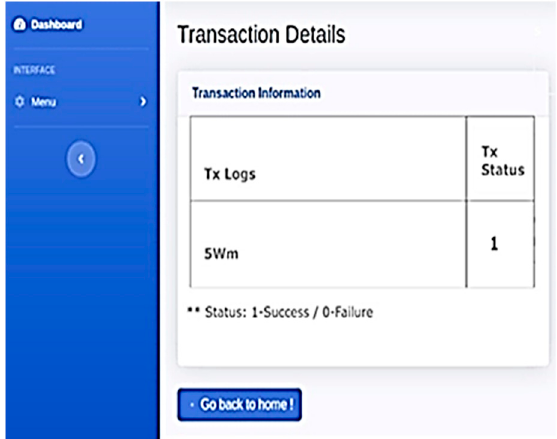
Figure 15. Accounts status after transactions.